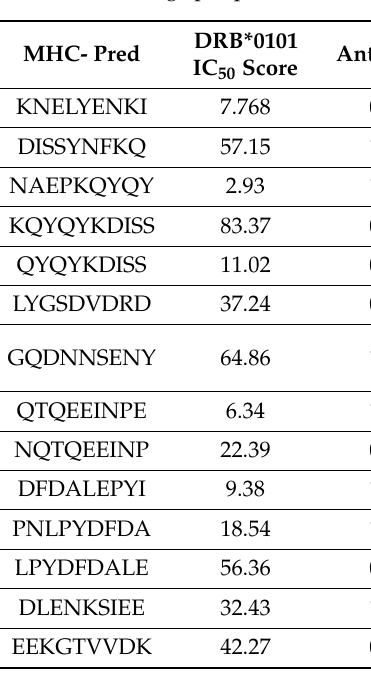
Table 5. MHC-Pred results, antigenicity, allergenicity, solubility, and toxin-pred profiling are consid- ered in shortlisting